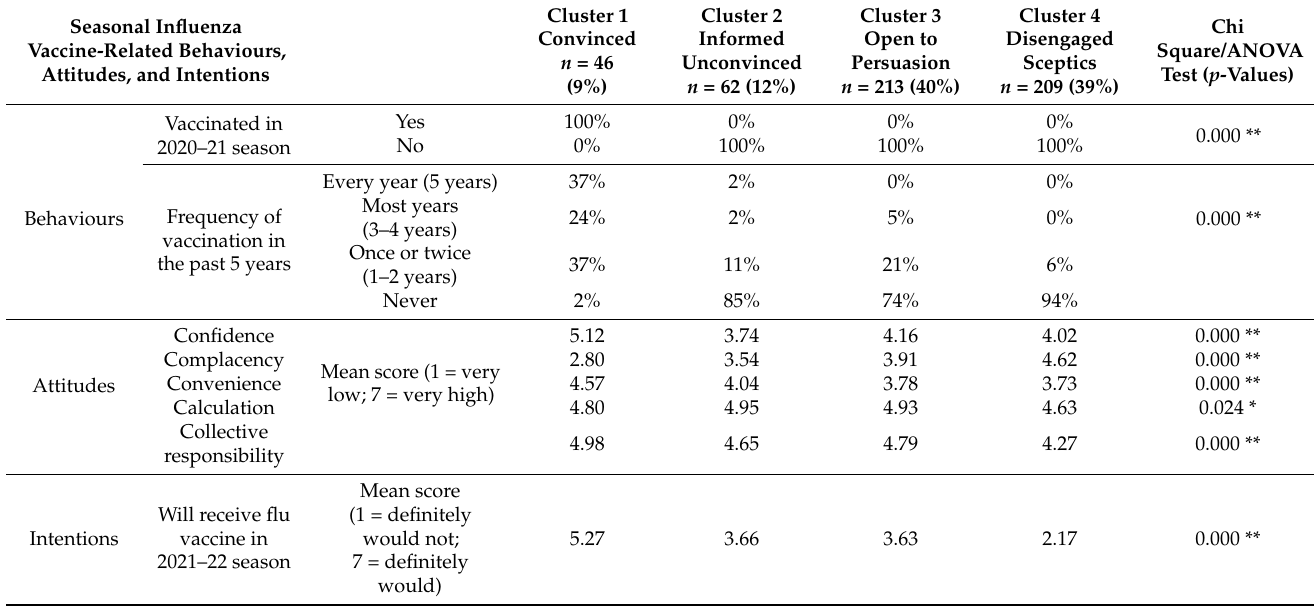
Table 5. Seasonal influenza vaccine-related behaviours, attitudes, and intentions by